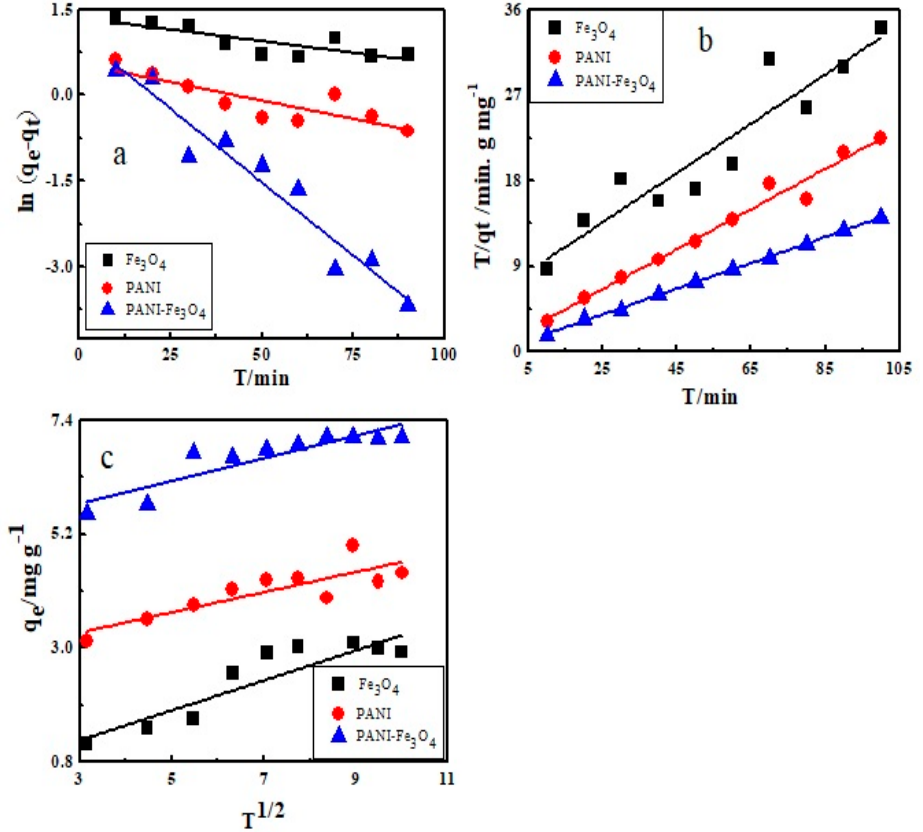
Figure 12. Kinetics models: ( a ) First order and ( b ) second order kinetics, ( c ) intra-particle diffusion model of adsorption of BB3 dye on Fe 3 O 4 , PANI, and PANI/Fe 3 O 4 composite. Table 4. Parameters of Kinetics models of BB3 adsorption onto Fe 3 O 4 , PANI, and PANI/Fe 3 O 4 composite. Pseudo 1st Order Pseudo 2nd Order